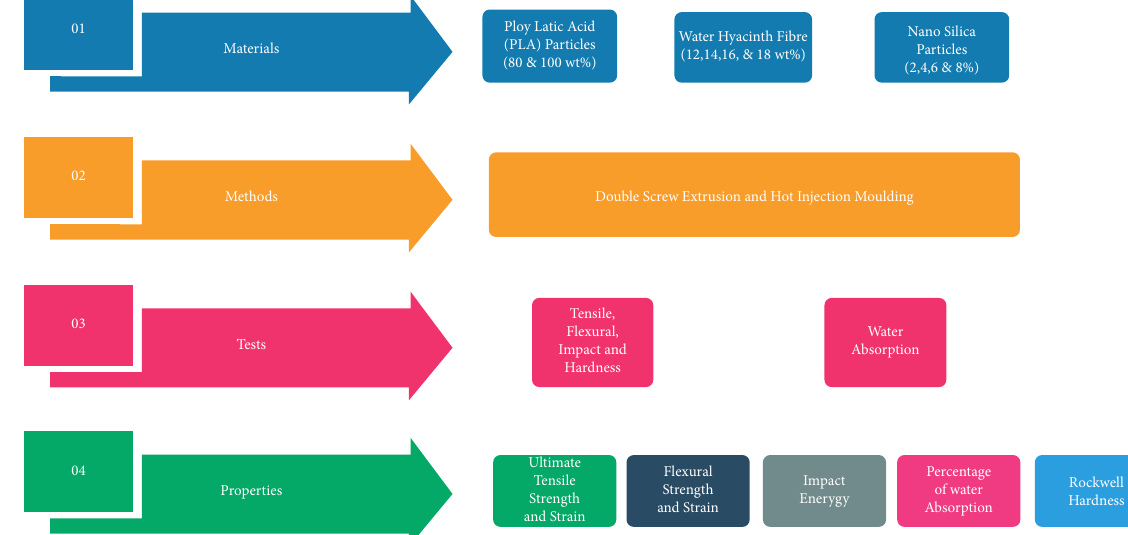
Figure 3: Execution methodology of this experimental research work. Table 1: Physical, chemical, and thermal properties of silica. Chemical composition Silica 46.83% and oxygen